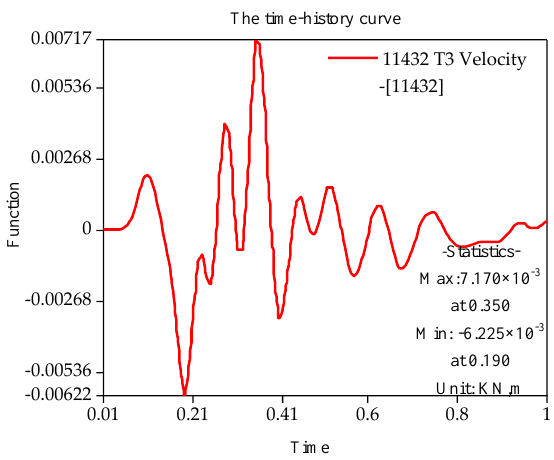
Figure 14. T3 Vibration curve on the basement of perilous rock. The location of blasting leading to the movement of the vibration curve on the base- ment of perilous rock at T1 and T2 is obviously opposite to T3, and the total vibration curve is coupled by T1 to T3. Furthermore, in terms of single velocity, T1 and T2 appear to be the peak; meanwhile, T3 is the minimum within 0.21, and the vibration velocity of T3 attains the maximum of 0.72 cm/s within 0.35 s. The total vibration velocity on the basement of the perilous rock reaches a maximum value of 1.19 cm/s within 0.36 s. The vibration velocity gradually decays after attaining the maximum